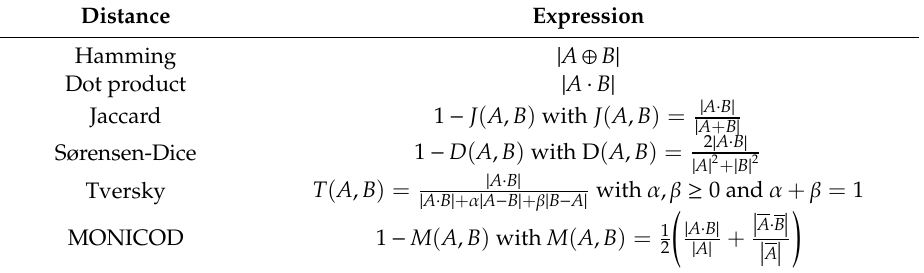
Table 1. Distances between binary templates, expressed in terms of logical operators, where | A | is the number of ones in vector A . A corresponds to the expected template. B is the template extracted from the image capture. In the case of the MONICOD distance the denominators of the expression are fixed and can be pre-calculated which speeds up the calculation of the distance